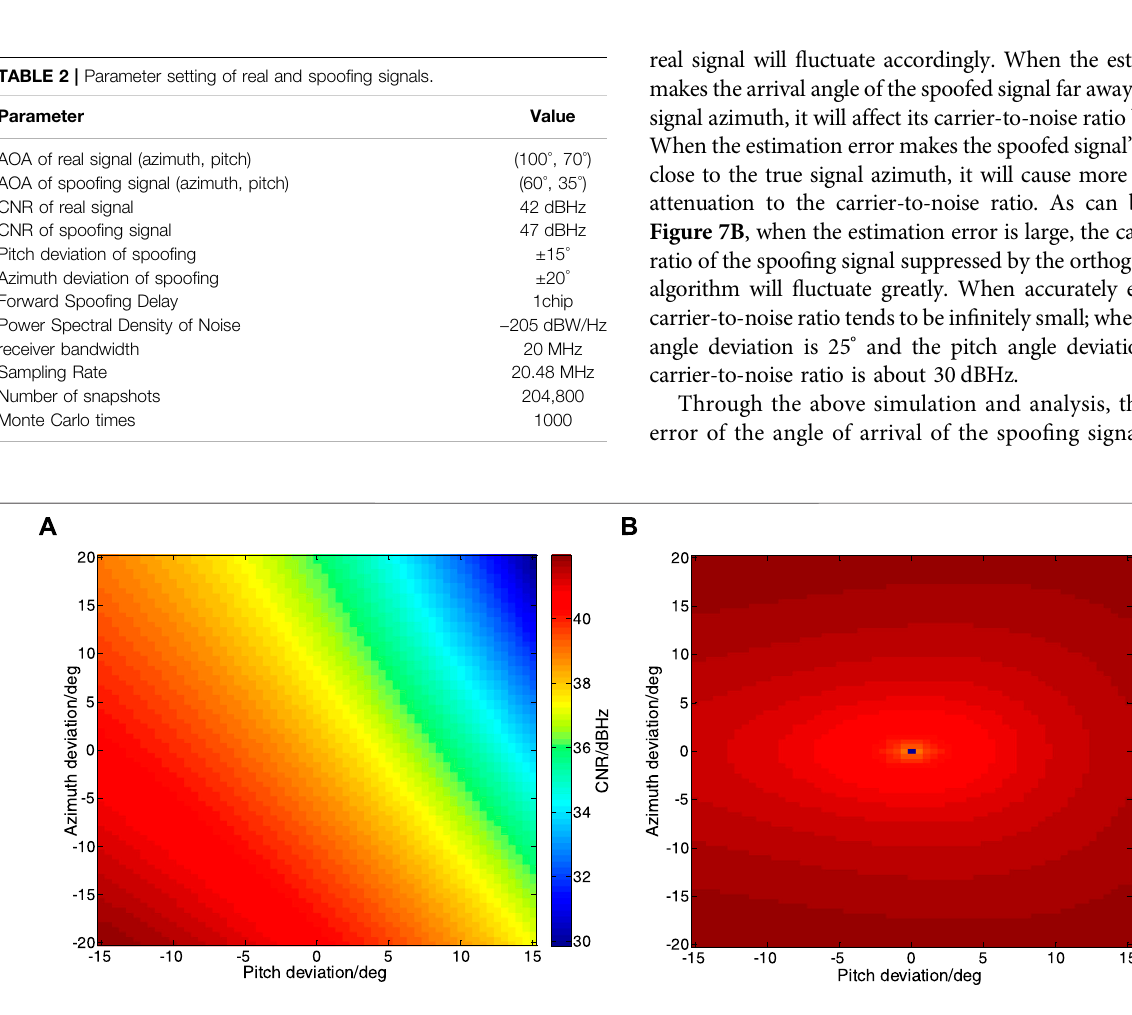
FIGURE 7 | Effect of Arrival Angle Estimation Error on Signal Carrier-to-Noise Ratio. Real signal is. shown in fi gure (A) , and spoo fi ng signal is shown in fi gure (B) .